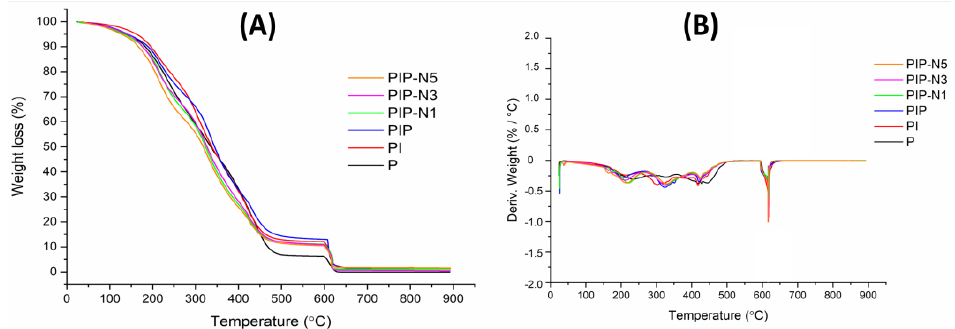
Figure 6. ( A ) TGA curves and ( B ) DTG curves of the neat polymer films and sustainable Pickering films. Table 2. Decomposition temperatures of biocomposite films at 10% (Td 10 ), 50% (Td 50 ), and 90% (Td 90 ) residual